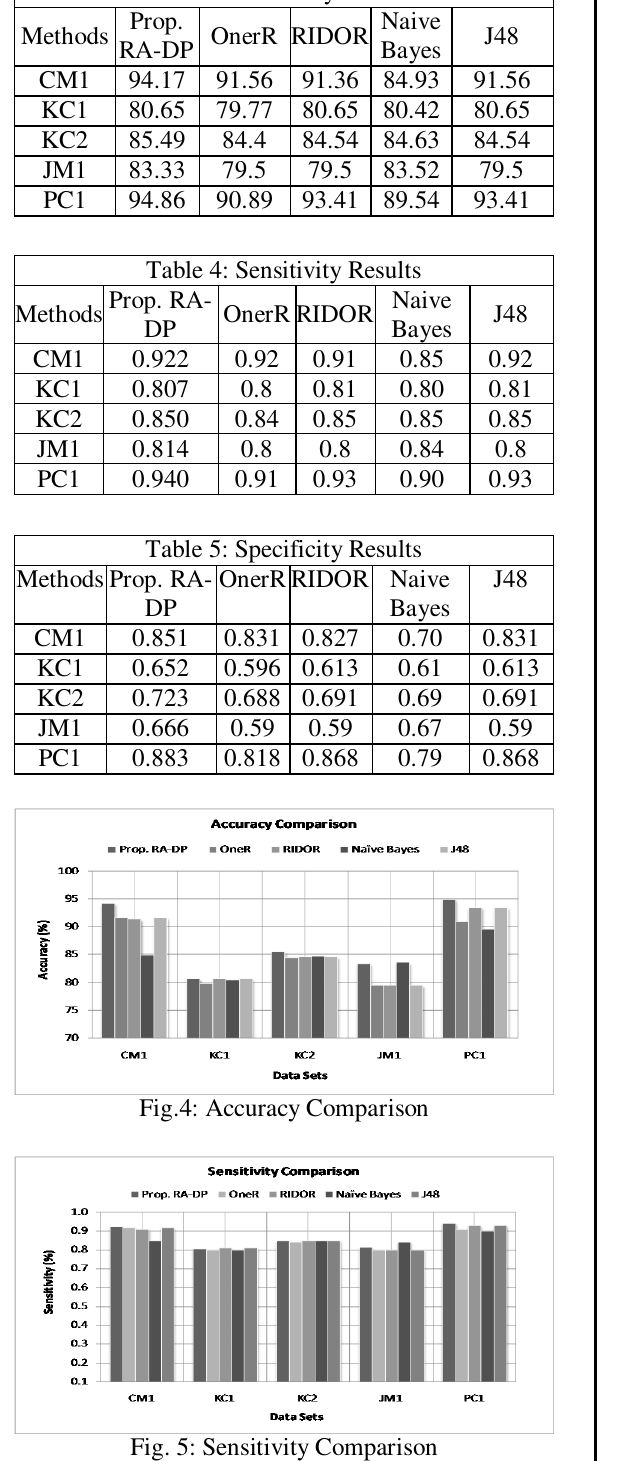
Table 3: Accuracy Results Prop. Methods OnerR RIDOR RA-DP